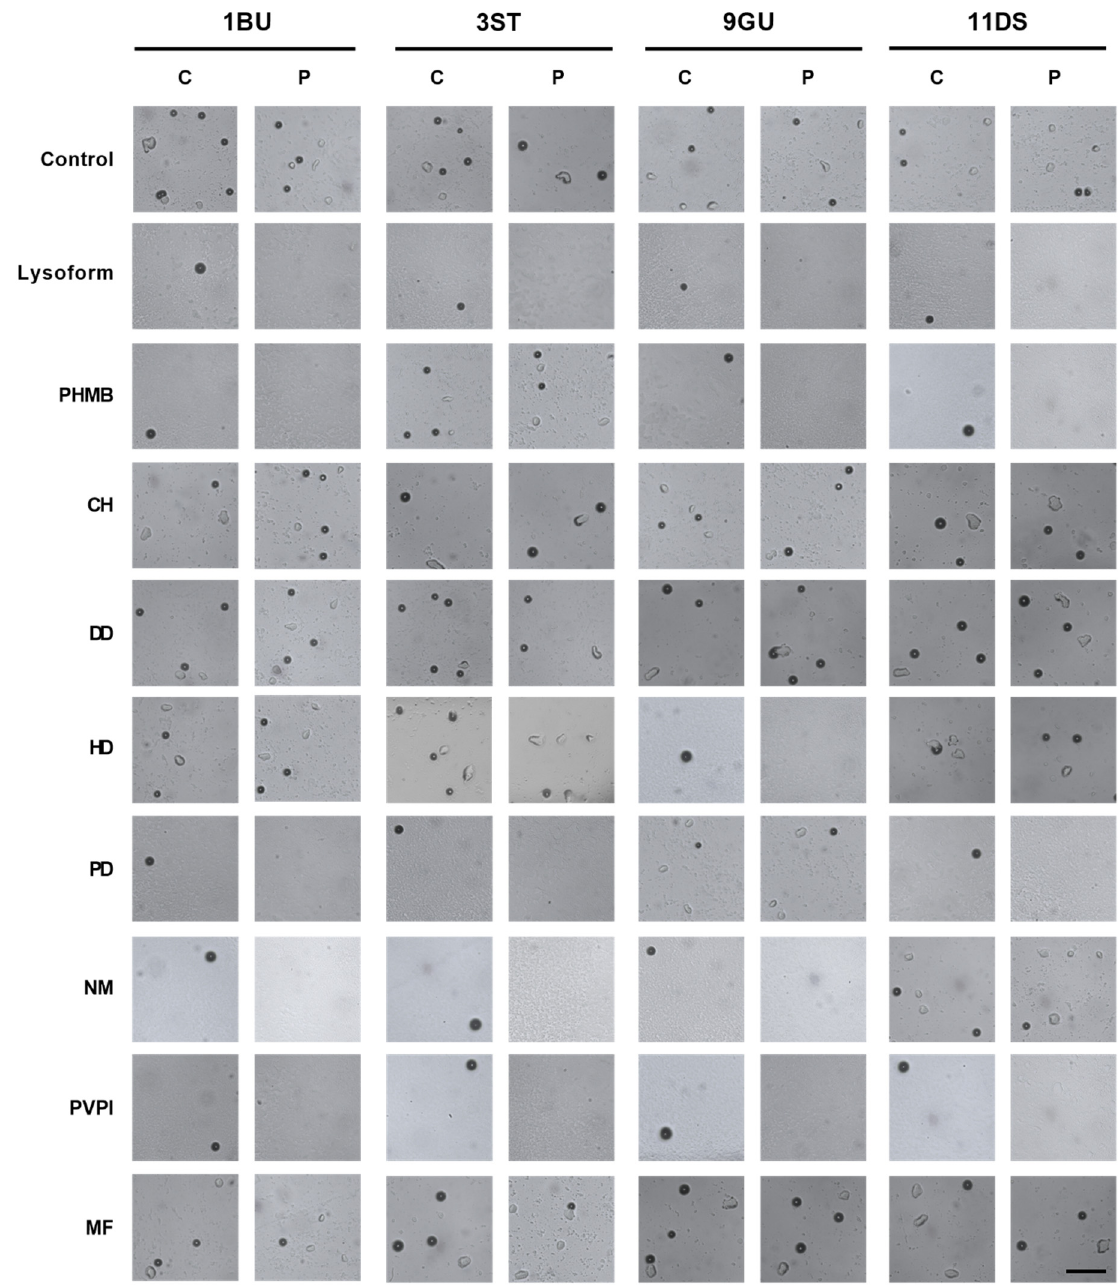
Figure 2. Impact of the drug treatment on the excystment and growth behavior of A. castellanii 1BU, 3ST, and 9GU and A. hatchetti 11DS cysts on non-nutrient agar E. coli plates. Cysts were incubated in PBS medium either in the absence of drugs (control) or with the drugs indicated; afterwards, they were diluted in medium to a cell density of 2000 cysts/mL. Then, 10 µ L of the solution (~20 cysts) was pipetted onto the centers of fresh non-nutrient agar E. coli plates. Cyst-inoculated plates were subsequently incubated at 30 ◦ C for up to 3 weeks, and images of the central and peripheral regions after 3 weeks of incubation are shown. Images are representative of five independent biological experiments. The disinfectant lysoform served as a killing control. Dark circular structures were identified as cysts, whereas transparent amorphous structures were identified as trophozoites. CH, chlorhexidine; DD, dibromopropamidine diisethionate; HD, hexamidine diisethionate; MF, miltefos- ine; NM, natamycin; PHMB, polyhexamethylene biguanide; PVPI, povidone iodine; PD, propamidine isethionate; C, central region; P, peripheral region. Scale bar, 100 µ